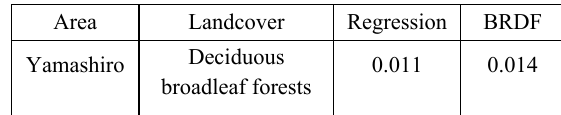
Table 4. Root-mean-square errors of estimated temporal albedo for Yamashiro, Japan, shown in Figure 6. “Regression” denotes the results applying multi-regression models for vegetation class to SGLI surface reflectance, and “BRDF” denotes the results using the BRDF model parameters provided in SGLI surface reflectance